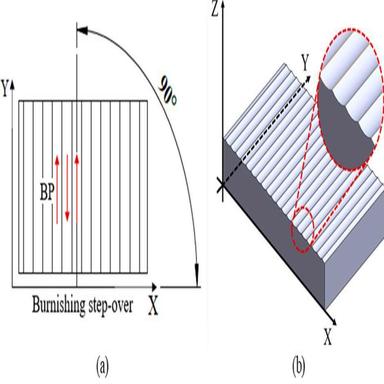
Surface texture generated by LPB: (a) burnishing path (BP) and (b) surface perspective.